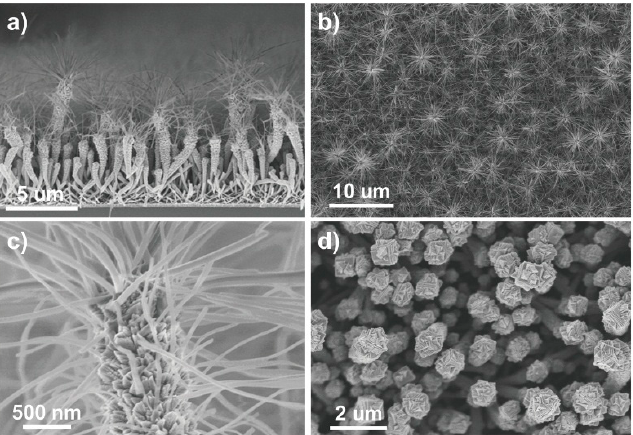
Figure 7. SEM images of TiO 2 multistacked nanotrees. The images show the different steps in multistacked nanotree formation ( a – d ). Used with the permission of the Royal Society of Chemistry, from Ref. [50]; permission conveyed through Copyright Clearance Center,